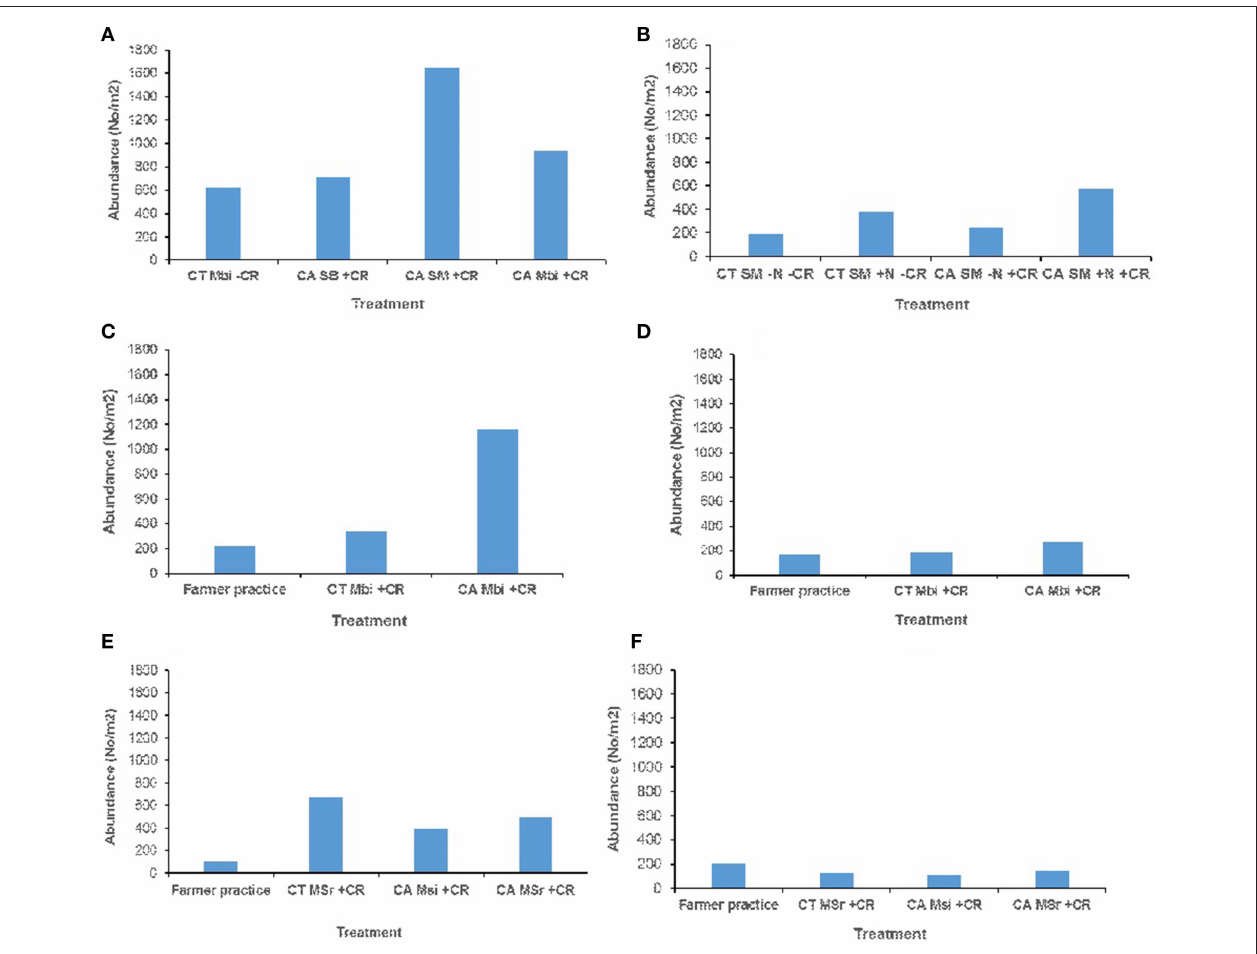
FIGURE 3 | Soil macrofauna abundance across trials of Embu, Kakamega, and Nyabeda. MT, Medium-term; LT, Long-term; CT, Conventional till; CA, Conservation agriculture (Zero till); SM, Sole maize; SB, Sole beans; MBi, Maize bean intercrop; MSi, Maize-soybean intercrop; MSr, Maize-soybean rotation; CR, Crop residue. (A) Embu MT (0-15 cm, p = 0.316); (B) Embu ST (15-30 cm, p = 0.075); (C) Kakamega MT (0-15 cm, p = 0.128); (D) Kakamega MT (15-30 cm, p = 0.383); (E) Nyabeda LT (0-15 cm, p = 0.285); (F) Nyabeda LT (15-30 cm, p =